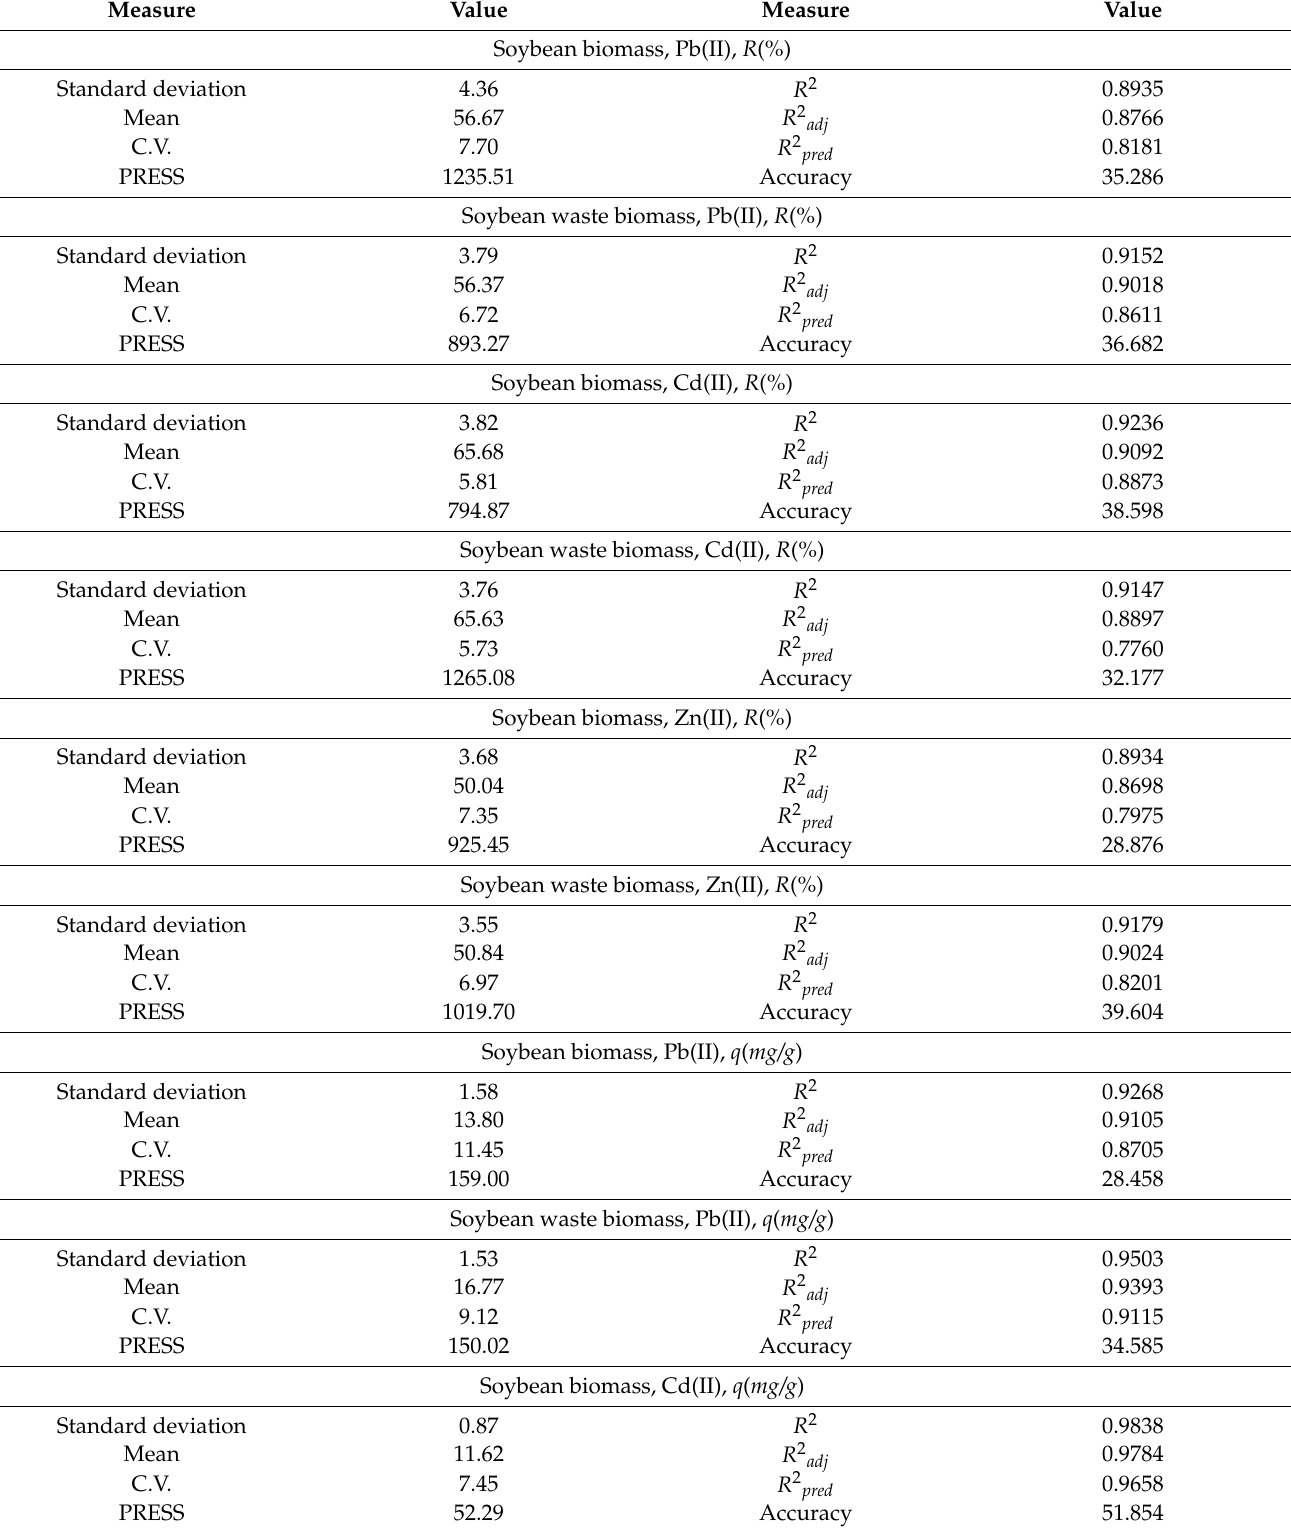
Table 9. Significance tests for RSM models developed for R (%) and q ( mg/g ) during biosorption